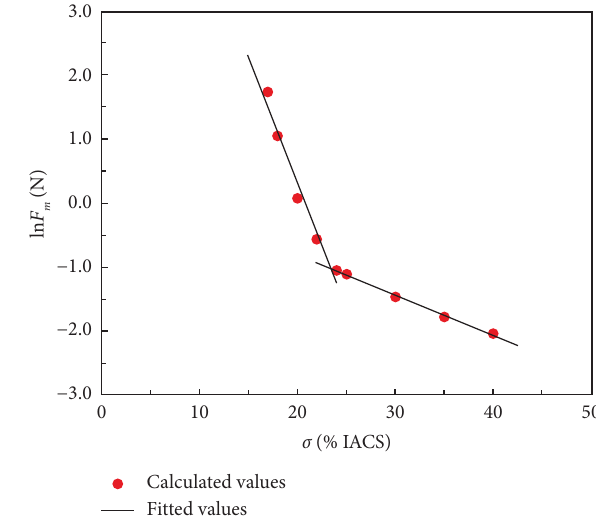
c when the value of σ is 15% IACS.